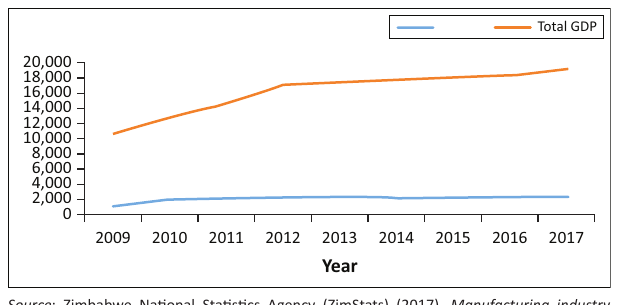
FIGURE 4: Manufacturing sector’s gross domestic product contribution at constant (2012) prices (in million